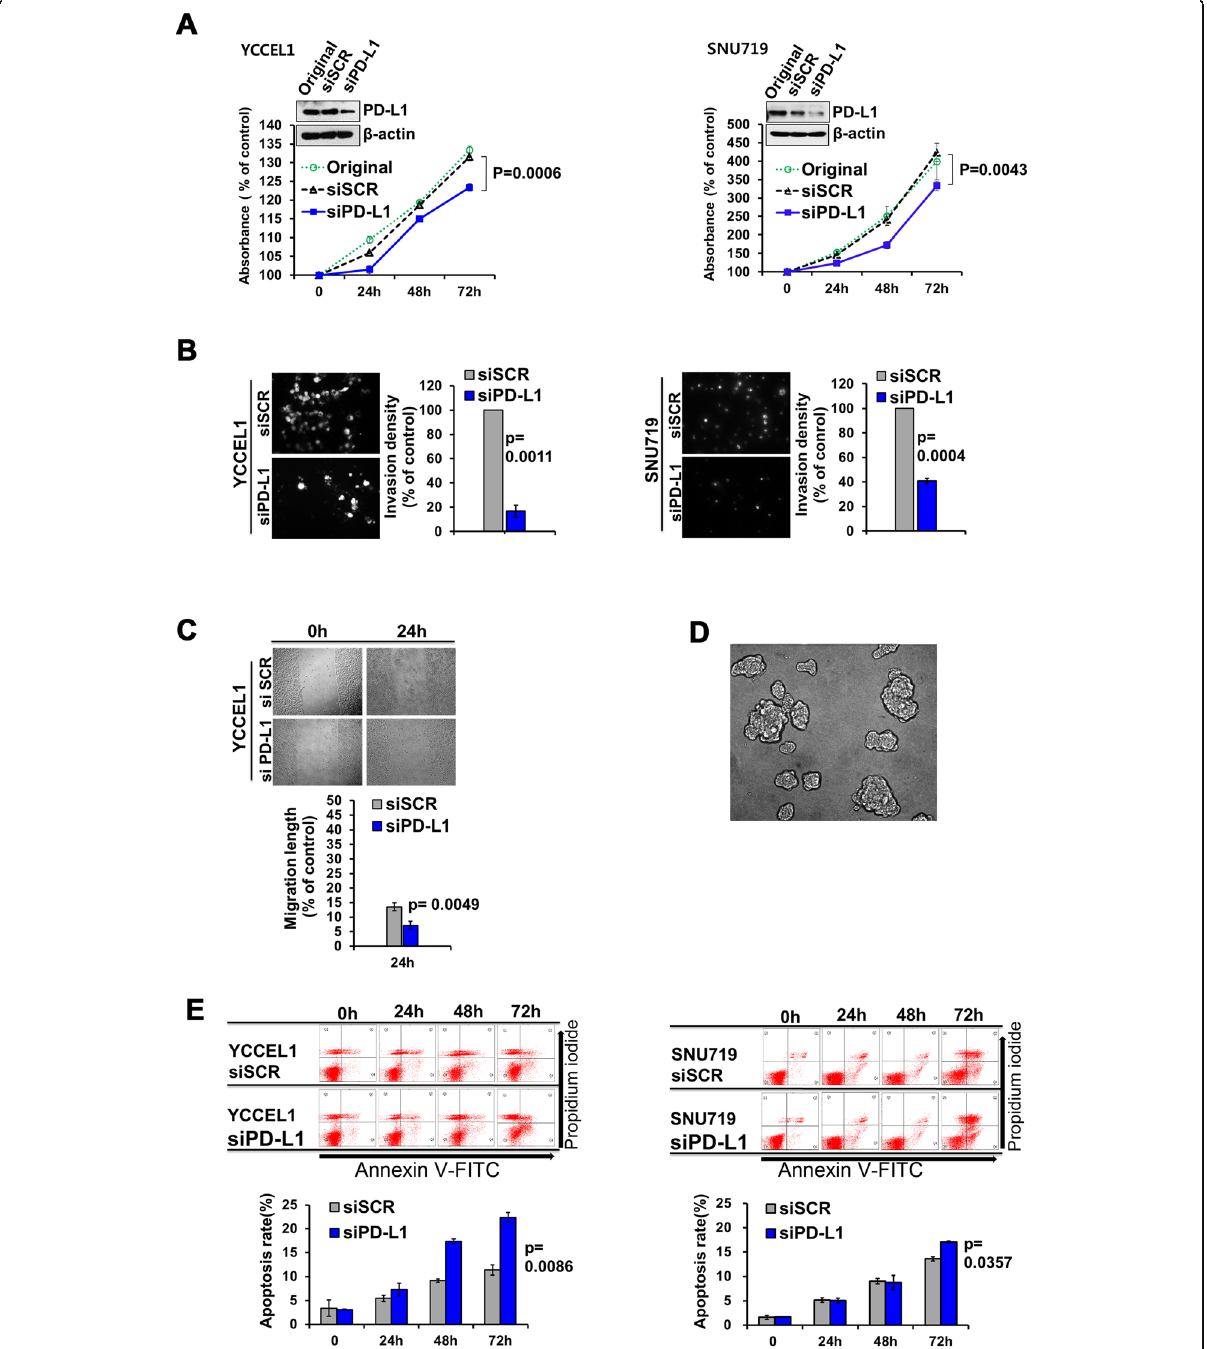
Fig. 5 Effect of PD-L1 knockdown on cell biologic properties in EBV-positive gastric carcinoma cell lines. In YCCEL1 (left column) and SNU719 cells (right column), cell proliferation ( a ), invasion ( b ) and migration ( c ) are lower in PD-L1-specific siRNA transfected cells than scrambled siRNA- transfected cells, and apoptosis ( e ) is higher ( P < 0.05). d There was a limitation on a wound-healing assay for migration in SNU719 cells; they grew in an aggregate pattern and thus, were not scratched with a pipette. X-axis